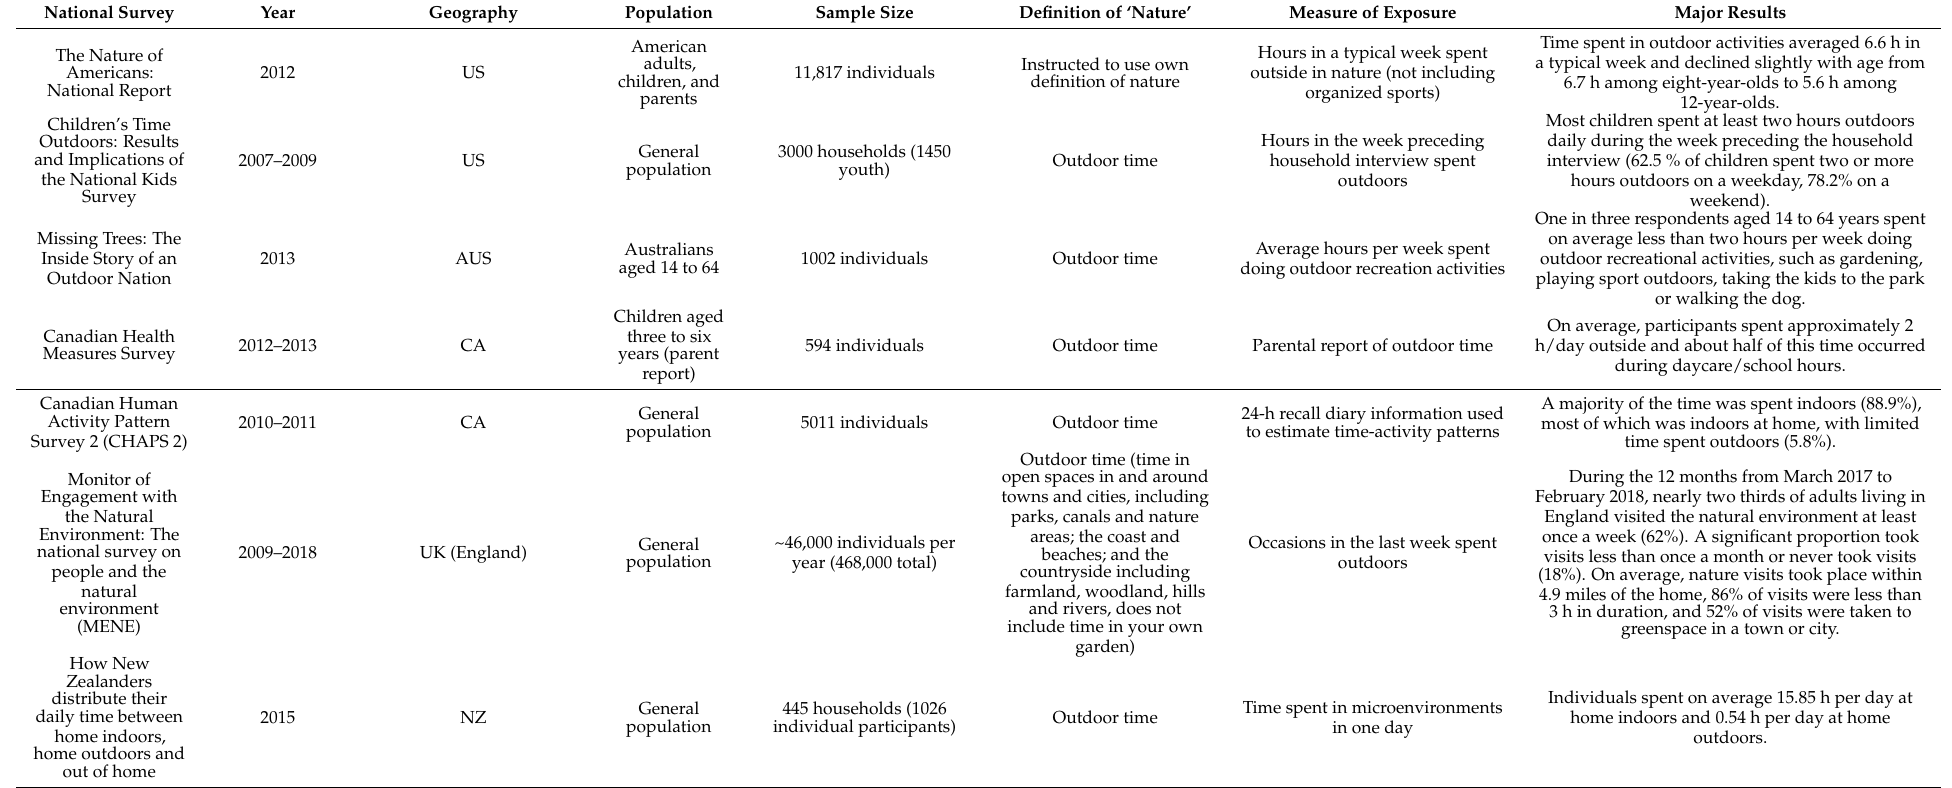
Table 1. Population-level data on time spent outdoors in nature collected in ten national surveys of populations within the United States, Canada, the United Kingdom, Australia and New